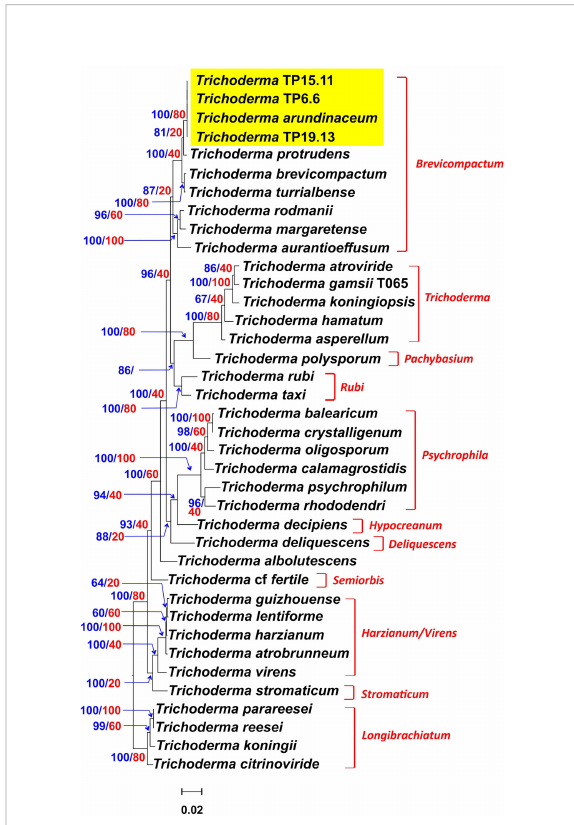
FIGURE 2 Trichoderma species tree inferred by maximum likelihood (ML) analysis of full-length amino acid sequences deduced from the full-length coding regions of fi ve housekeeping genes. Numbers on branches are bootstrap values (blue type) based on 1000 pseudoreplicates and gene concordance factors (GCF, red type). Lineage names, as described previously (Kubicek et al., 2019; Gutie ́ rrez et al., 2021), are indicated in red type to the right of the tree. Yellow rectangle highlights the positions of the three isolates recovered during the current